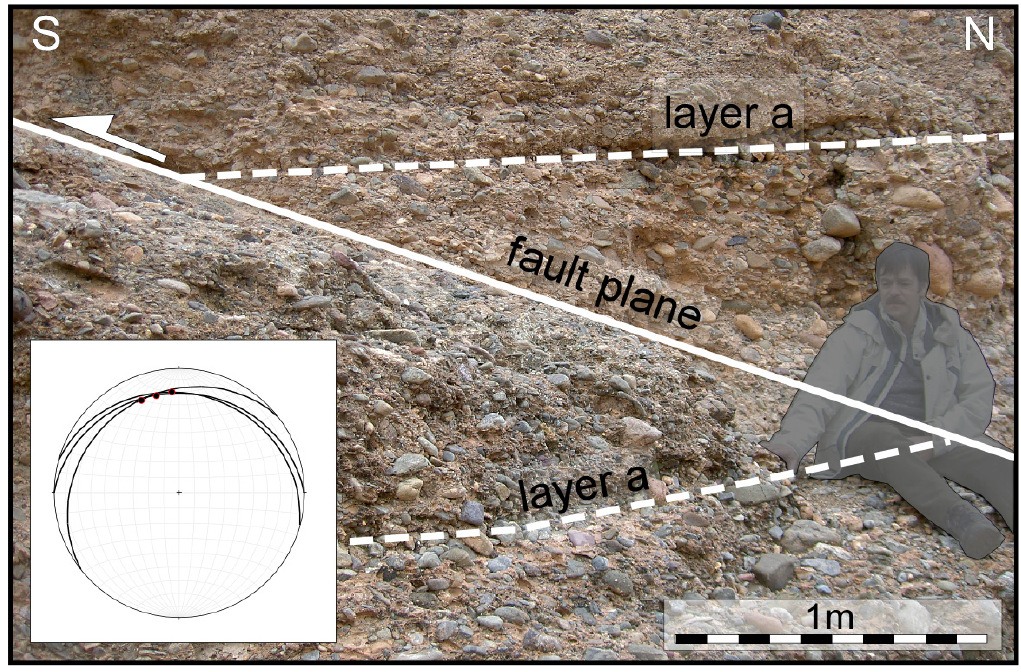
Figure 10. Interpretation of a field photograph showing a minor fault affecting Q1 at the Tabia area, looking from the east. See location in Figures 2 and 3. This fault, which dips 21º to the north and has a displacement of 2.5 m, is only recognizable at the well-cemented base of Q1. The fault plane is exhumed and exposes the striae plotted in the